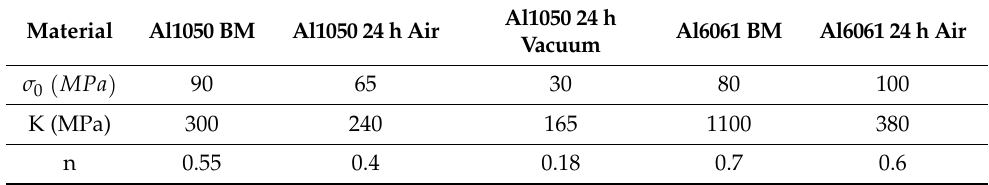
Table 5. The flow stress relation characterized from tension tests of the heat-treated materials.